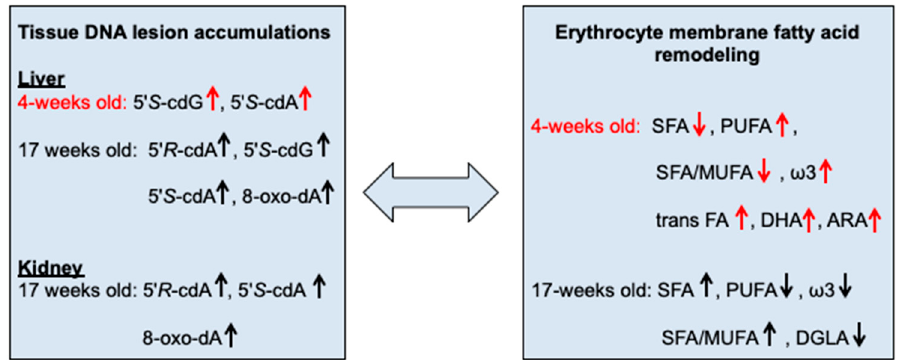
Figure 5. The diagram shows changes in the biological compartments found in the model of tumor-bearing SCID mice compared with SCID mice without tumor implantation at 4 weeks and 17 weeks of age; up-arrow: increase, down-arrow: decrease.